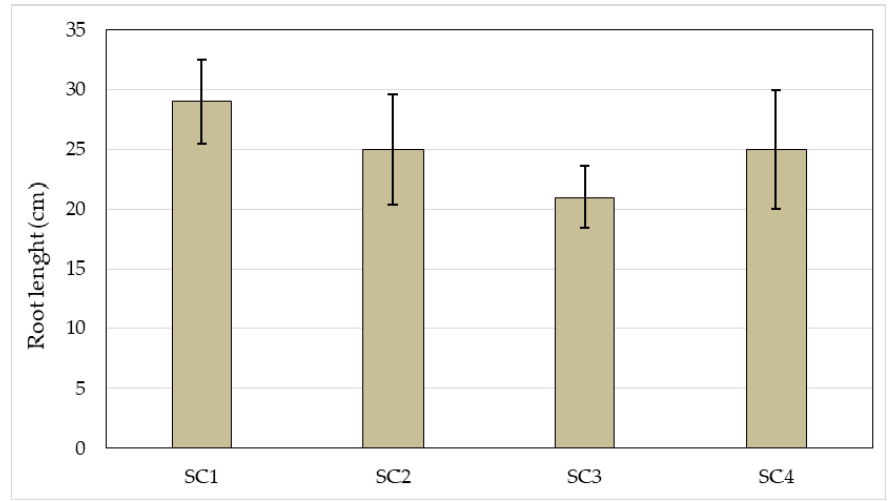
Figure 10. Mean values of root length related to the four Substrate Compositions (SC). The bars stand for standard deviation values ( n = 4).